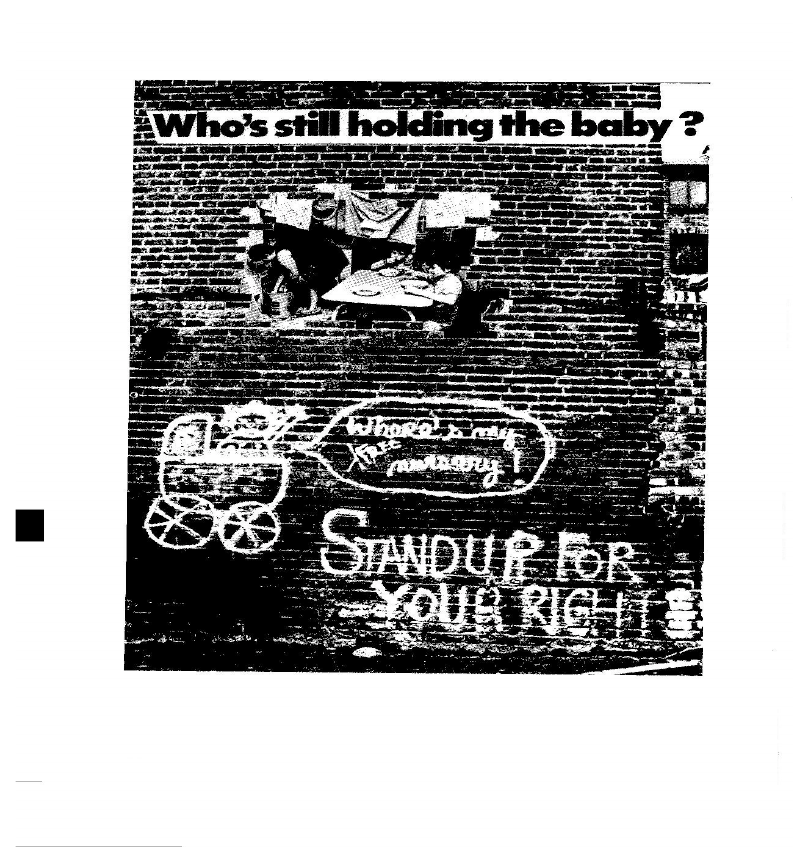
Figure 2: Hackney Flashers Who’s Still Holding the Baby?